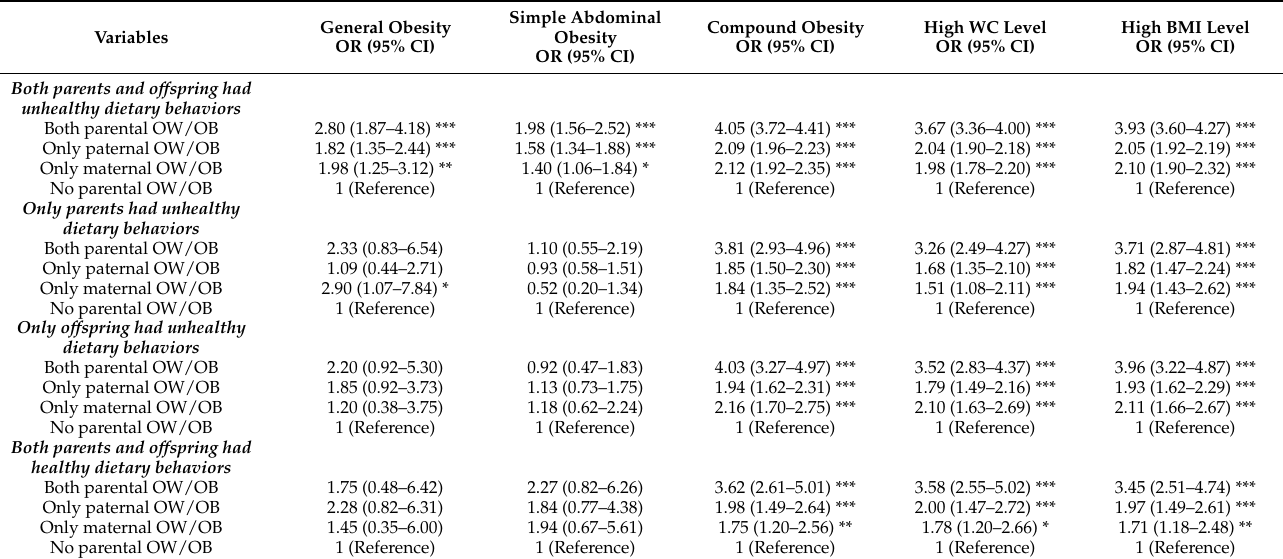
Table 3. Association of OW/OB between parents and offspring by the combination of dietary behaviors in two